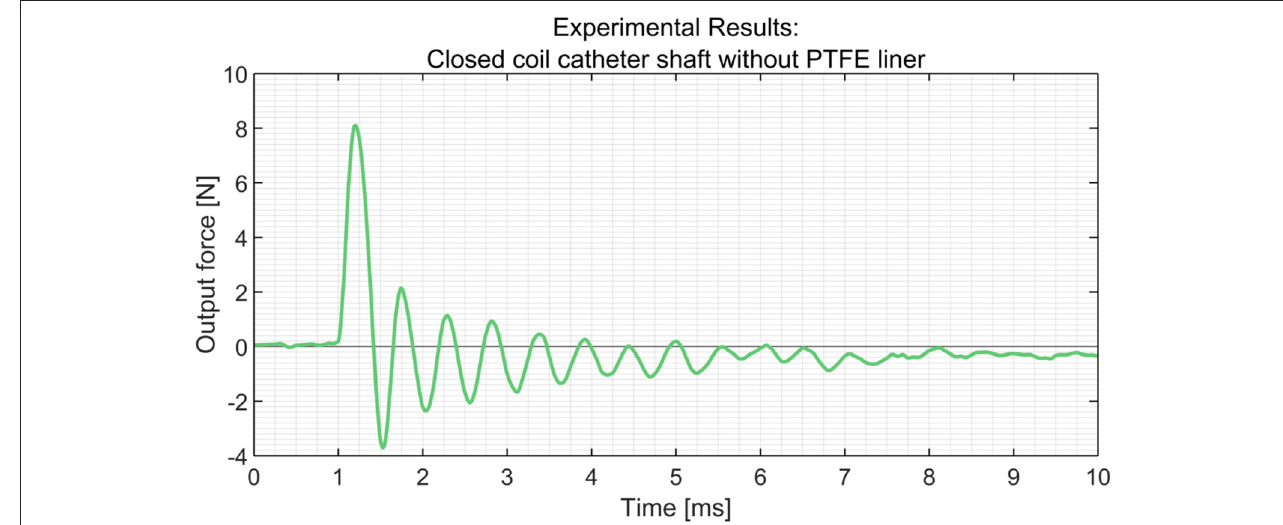
FIGURE 9 | Experimental results obtained from the load cells using the closed coil catheter shaft without PTFE liner.